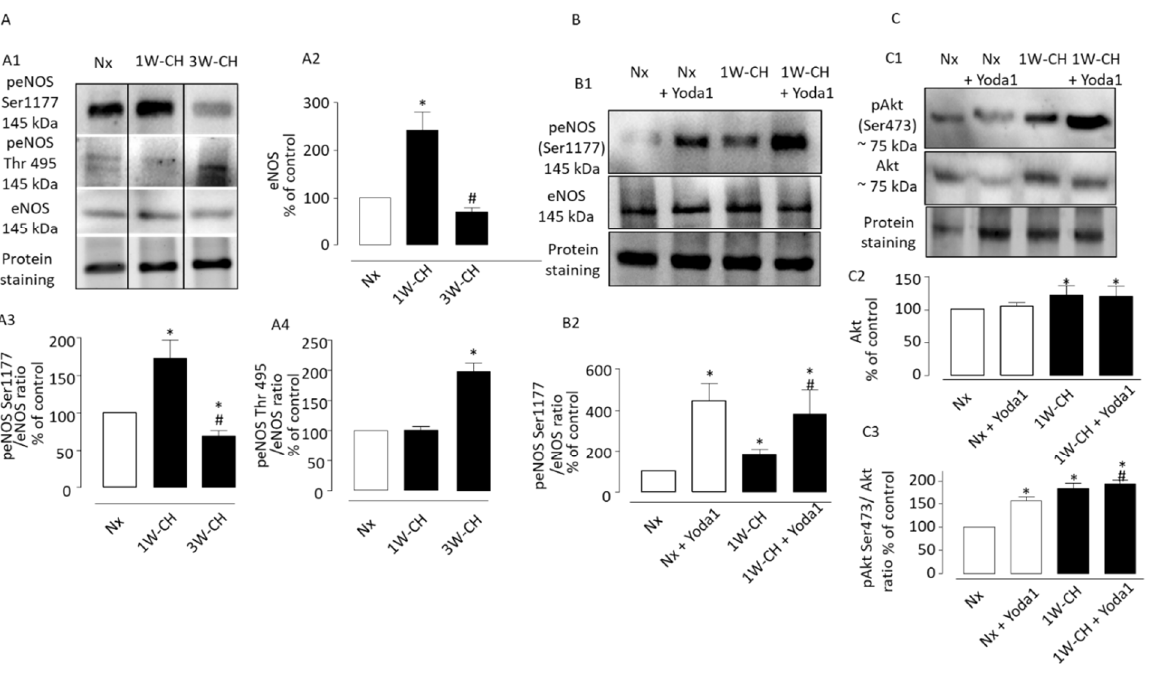
Figure 8 . Piezo1 activation induces phosphorylation of the Akt-eNOS pathway in IPA. Effect of chronic hypoxia on expression and phosphorylation of Akt-eNOS pathway in IPA. ( A1 ) Representative images of total eNOS, and phospho-eNOS in IPA from rats exposed to Nx or 1W-CH (early stage CH-PH) or 3W-CH (later stage). ( A2 ) Graphs showed quantified relative signal intensity normalized (% of control, Nx) to total protein staining in IPA from rats exposed to Nx or 1W-CH or 3W-CH. The eNOS phosphorylation of Ser1177 ( A3 ) or Thr497 ( A4 ) was analyzed and compared to eNOS total levels under the same conditions. ( B ) Yoda1 led to the activation of eNOS by phosphorylation at Ser1177 in IPA from Nx or 1W-CH. ( B1 ) Representative image of peNOS, ( B2 ) graphs show data for statistical analysis. ( C ) Akt total levels were increased in 1W-CH PH in comparison to Nx. In addition, Yoda1 increased Akt phosphorylation at Ser473 in all experimental conditions. ( C1 ) Representative image of total Akt and pAkt. ( C2 ) Graphs from Akt quantified relative signal intensity normalized (% of control, Nx) to total protein staining and ( C3 ) pAkt was compared to Akt total levels. Results are expressed as mean ± SEM from four (Western blotting) experiments. * p < 0.05 compared to Nx and # p < 0.05 compared to